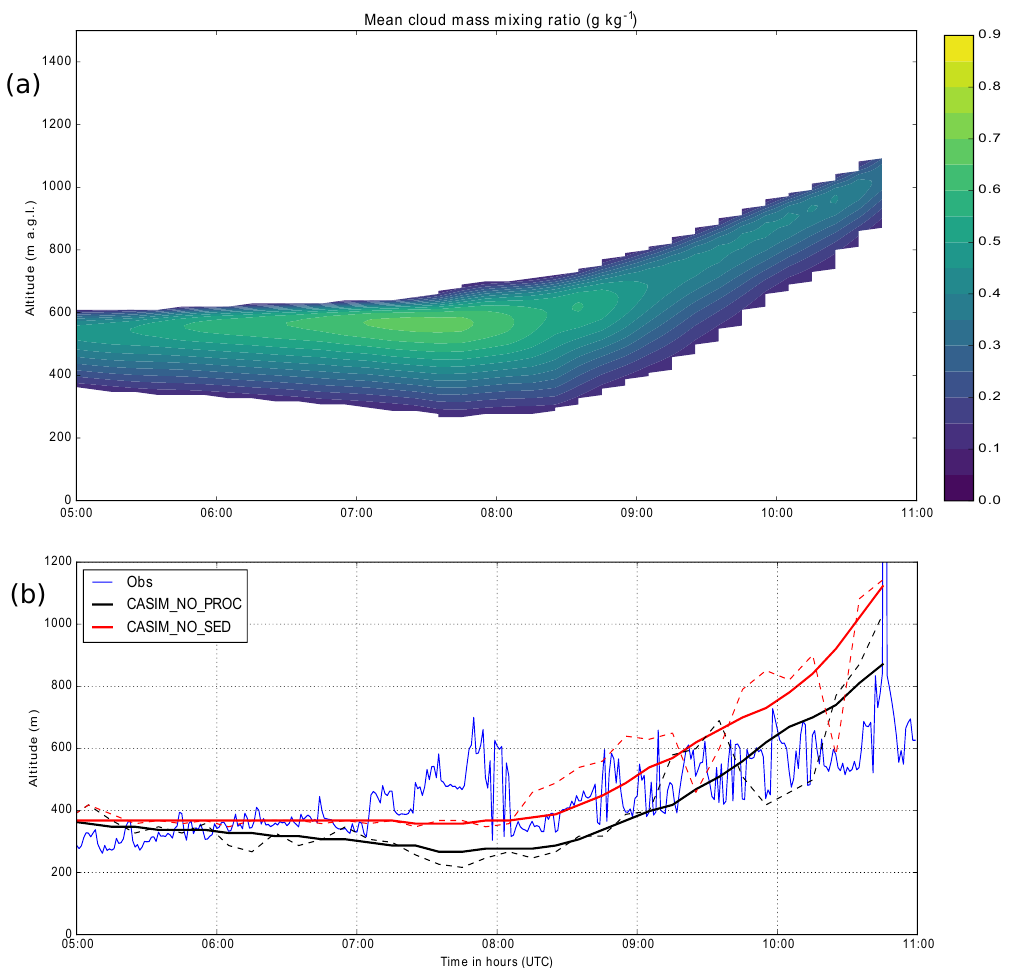
Figure 5. (a) Time–height plot of the mean cloud mass mixing ratio (gkg − 1 ) within the model domain from the CASIM_NO_PROC experiment. Values are calculated as temporal means every 10min. (b) Time series of cloud base height at Savé on 5 July 2016 (blue) derived from ceilometer measurements (Handwerker et al., 2016), and cloud base height diagnosed from CASIM_NO_PROC and CASIM_NO_SED using a threshold cloud liquid water mass mixing ratio of 0.1gkg − 1 . Solid black and red lines are the domain mean value; dashed black and red lines are the value at the centre of the model